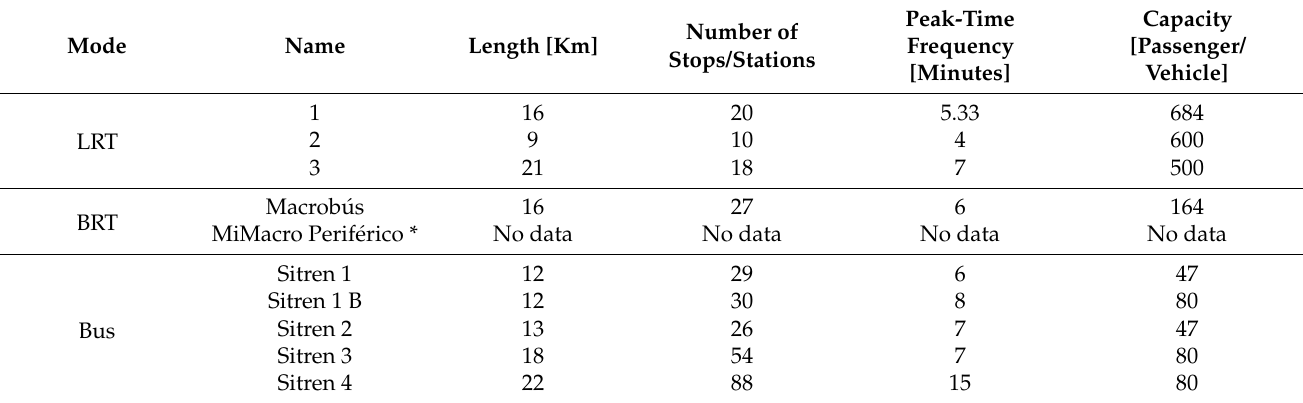
Table 1. Characteristics of Modes in the